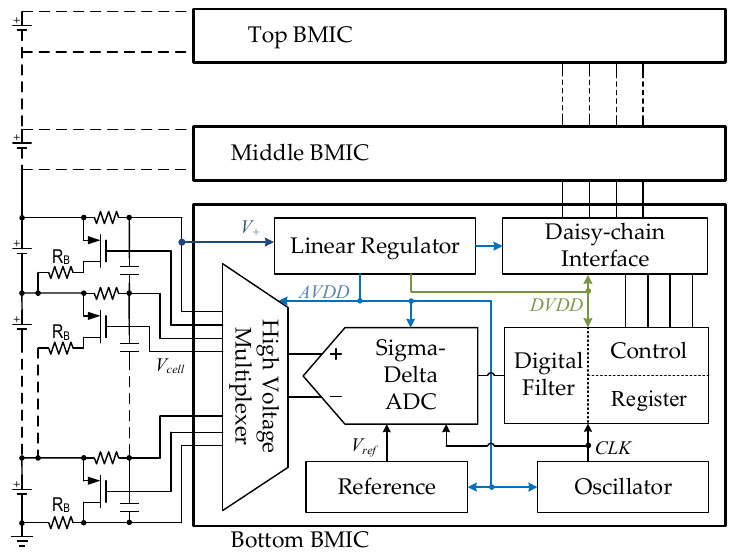
Figure 2. The structure of the proposed BMIC.